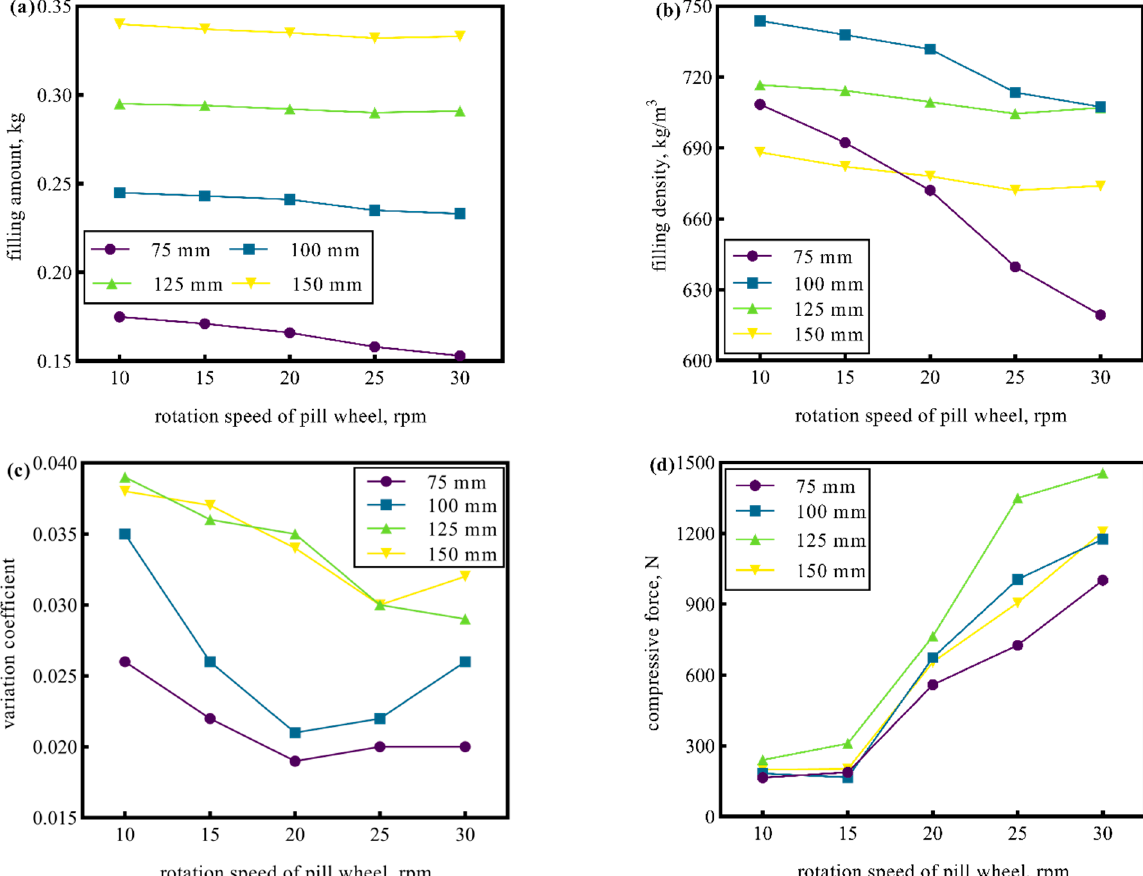
Figure 6. The effects of the grid widths on the working performance over the rotation speed of the discharge wheel: ( a ) The filling amount; ( b ) The filling destiny; ( c ) The discharge variation coefficient; ( d ) The compressive force of the pill particles.